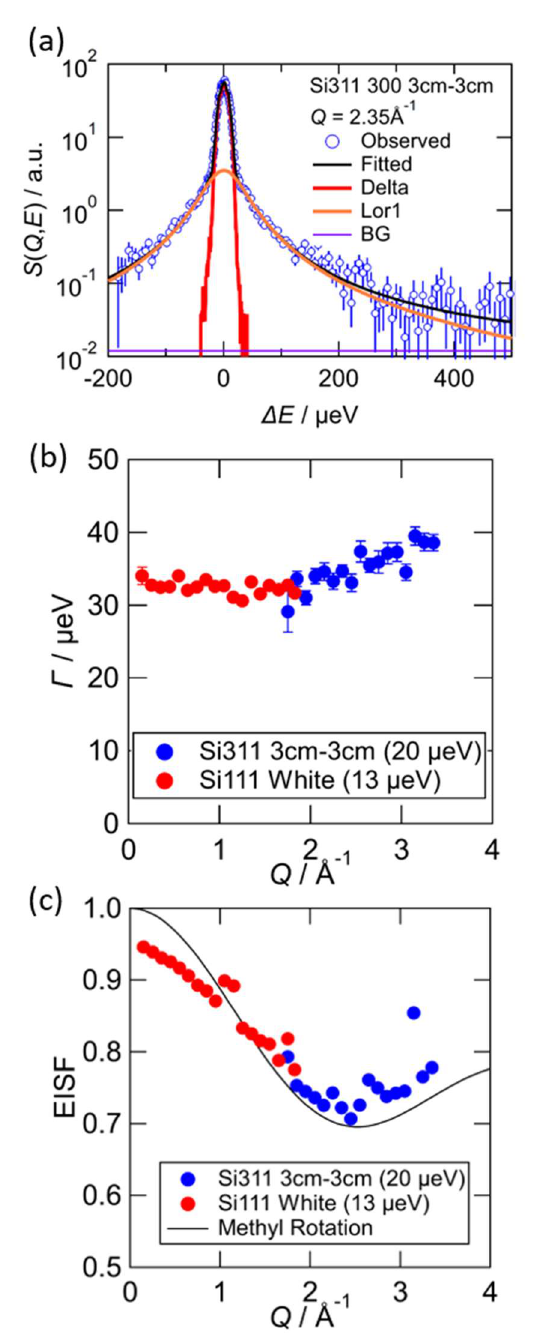
Fig. 6. QENS analysis of toluene at 40K. (a) A curve fitting with a delta plus a Lorentian functions together with a constant background which are convoluted by instrument resolution function. (b) The Q dependence of the Lorentzian width. (c) The elastic incoherent structure factor together with a theoretical curve assuming methyl